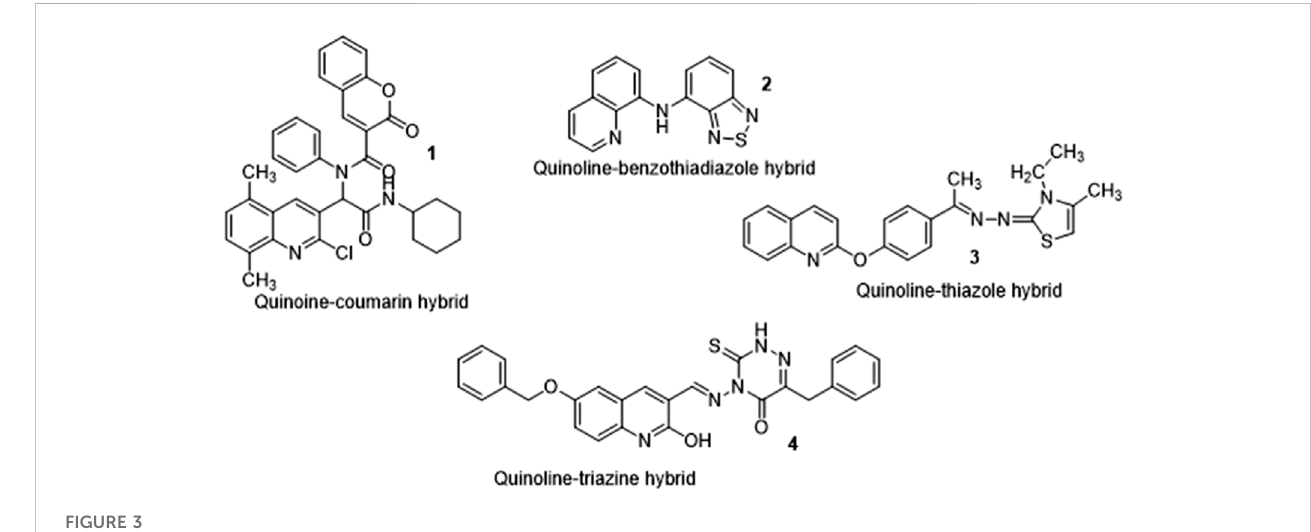
FIGURE 3 Structures of reported quinoline hybrids.